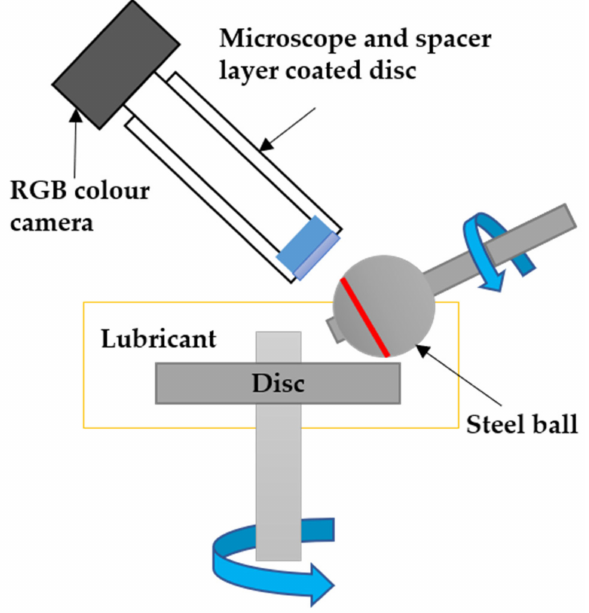
Figure 1. Schematic representation of MTM-SLIM test.